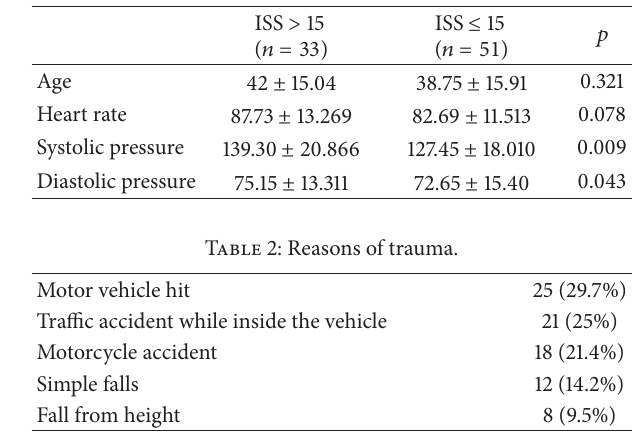
Table 1: Vital signs.